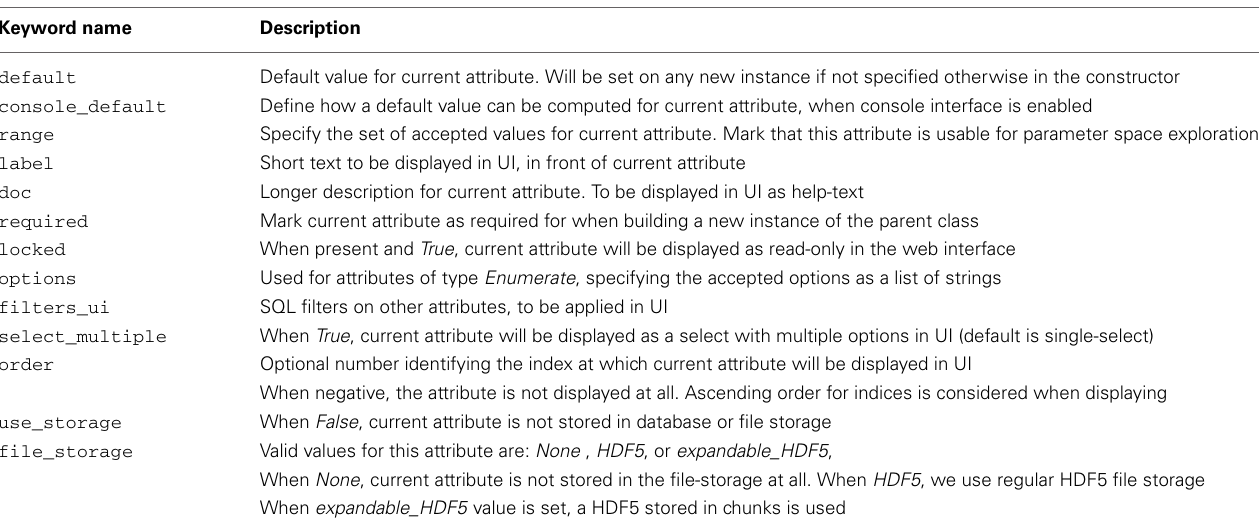
Table 1 | TVB currently available traited